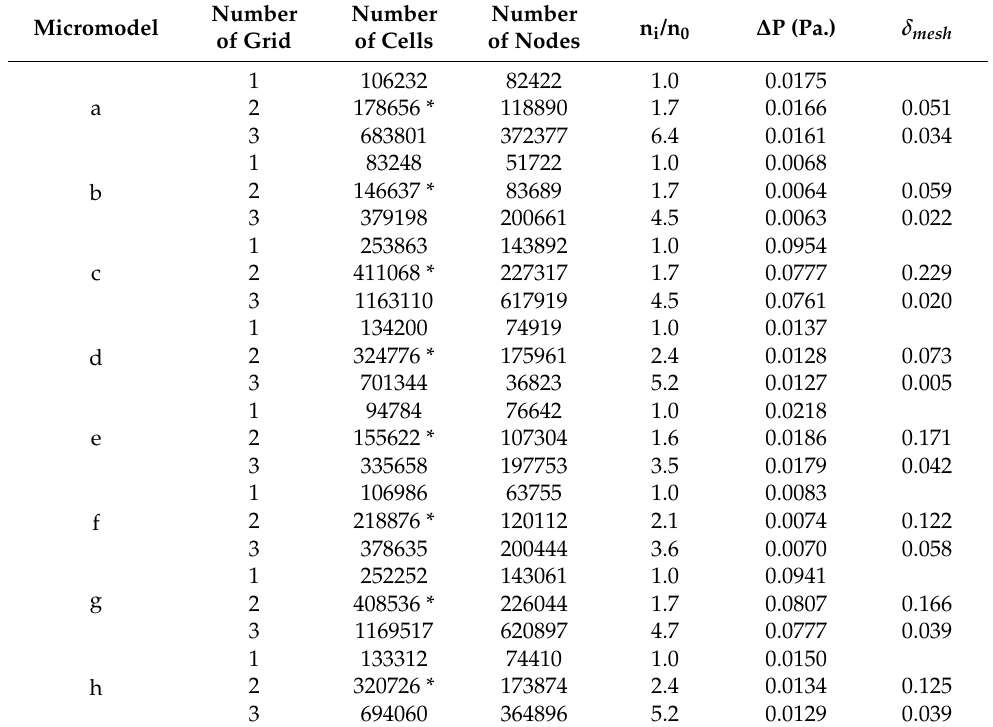
Table 4. Analysis of mesh independence.